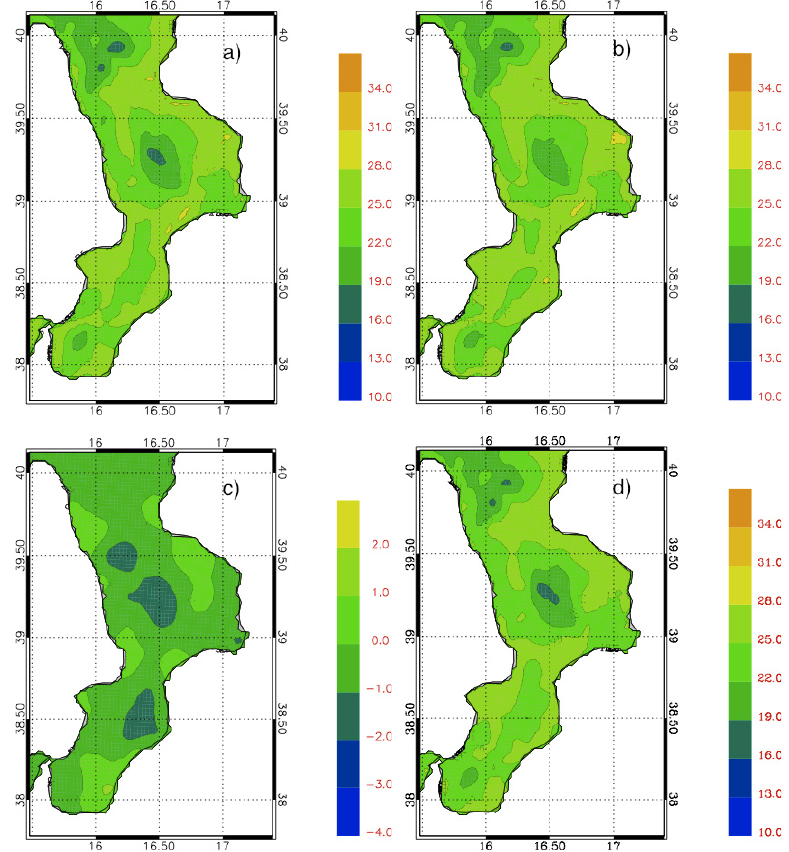
Fig. 6. (a) OI analysis for mean temperature on 18 June 2008; (b) As in (a) , but for the background field; (c) Difference between the OI analysis and background; (d) SI analysis for mean